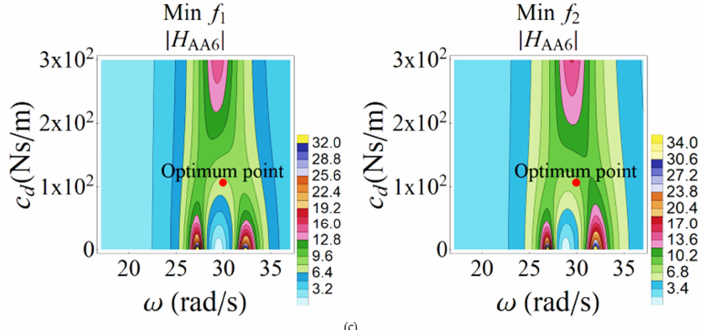
Figure 15. Contour plot of the 6th node vertical absolute acceleration transfer function | H AA 6 ( ω ) | with respect to frequency and ( a ) TMD mass coefficient, ( b ) TMD stiffness coefficient, and ( c ) TMD damping coefficient, considering f 1 and f 2 minimization for the first mode control.